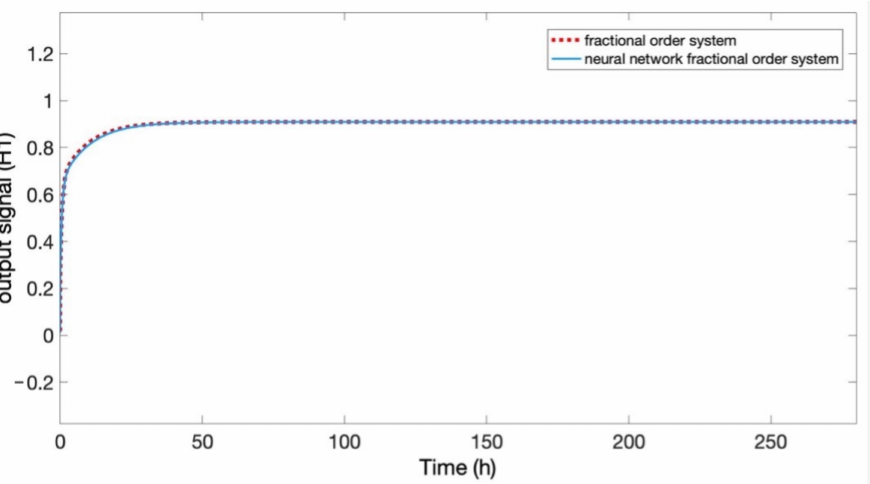
Figure 9. The comparison between the response of the Oustaloup approximation implemented using the first two neural networks and the response of the fractional-order system ( β = 0.53 <